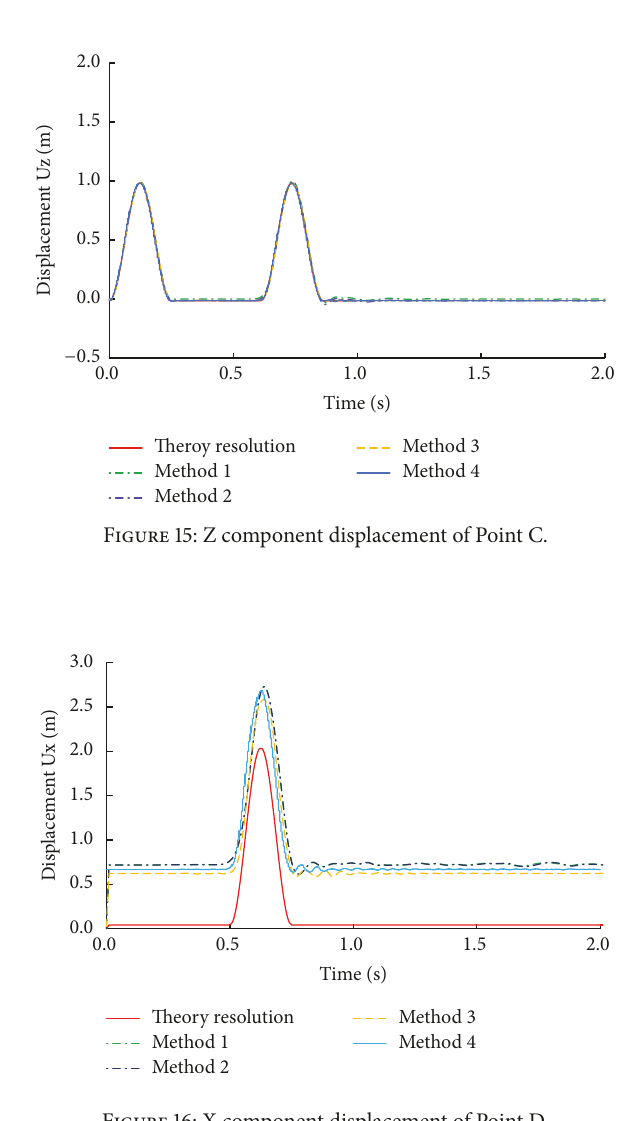
Figure 16: X component displacement of Point D.